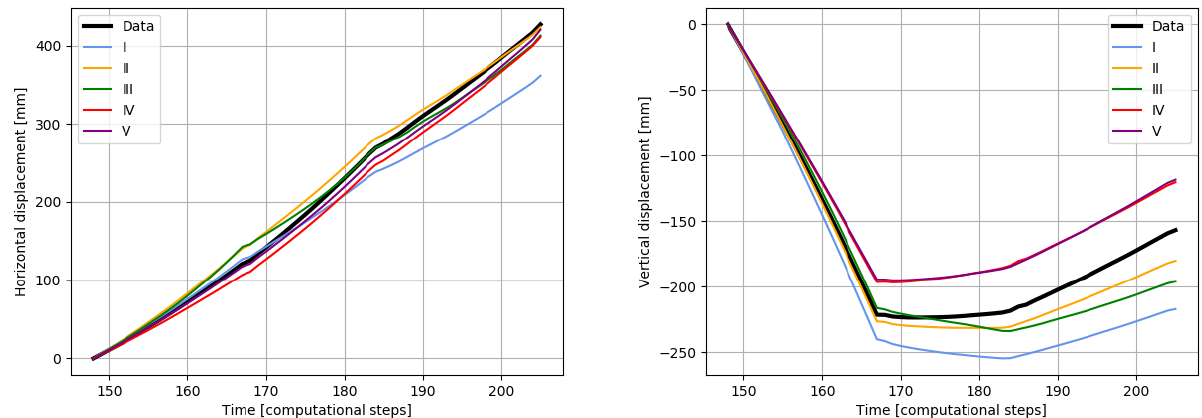
Figure 10: Results of horizontal (left) and vertical (right) displacement in benchmark U2.